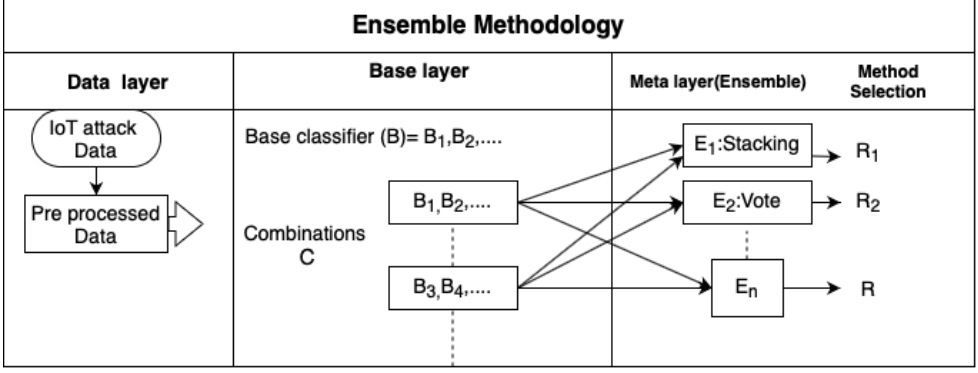
Figure 3. Selection of an ensemble